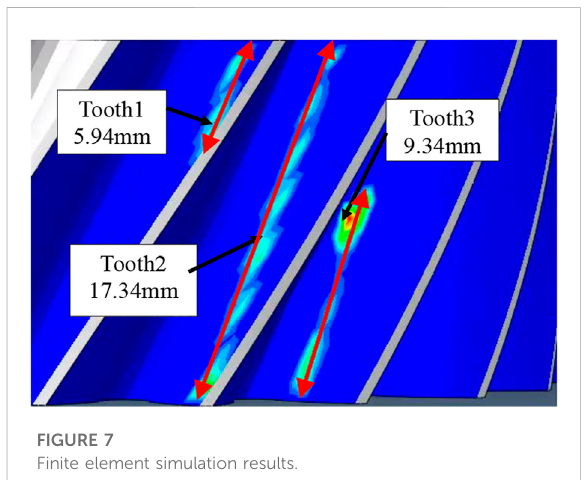
FIGURE 7 Finite element simulation